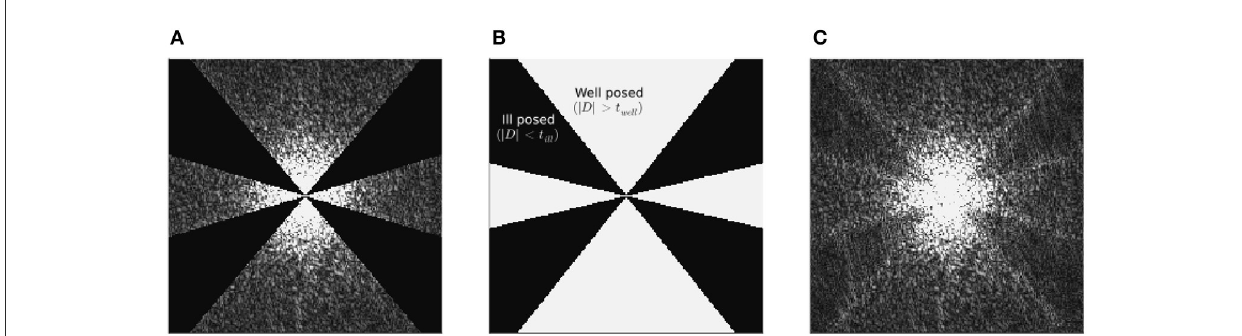
FIGURE1 Challenge dataset ground truth frequency spectrum (A) , together with incomplete spectrum reconstructed k-space (C) , using the incomplete spectrum method with the (XSIM-optimal) band limit given in (B) . All data are absolute (e.g., | ν | ) and slices are longitudinal (sagittal) in the frequency domain, and with the same grayscale (0 ... 100 [a.u.]). The band limit boundaries, although much less stark than in (A) , are still visible in the reconstructed spectrum, which may explain the doubling of streaking artifacts around the calcificaiton in incomplete spectrum QSM